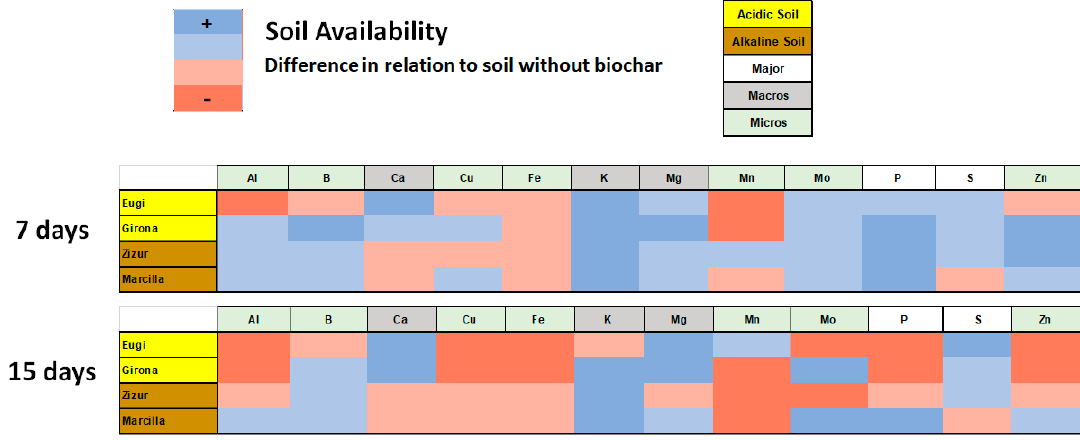
Figure 4. Nutrients availability over 7 and 15 days in soil solution by biochar effect.